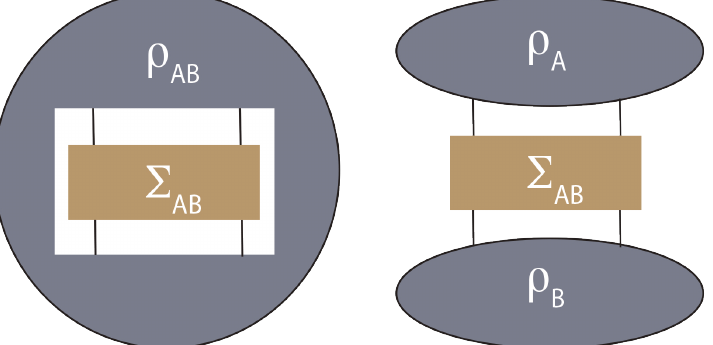
Figure 6. Diagrams classifying entanglement with density matrices. Left: An non-factorizable or entangled system with a generic probe Σ AB . Right : A separable system conditional upon a special class of probe Σ AB is also called